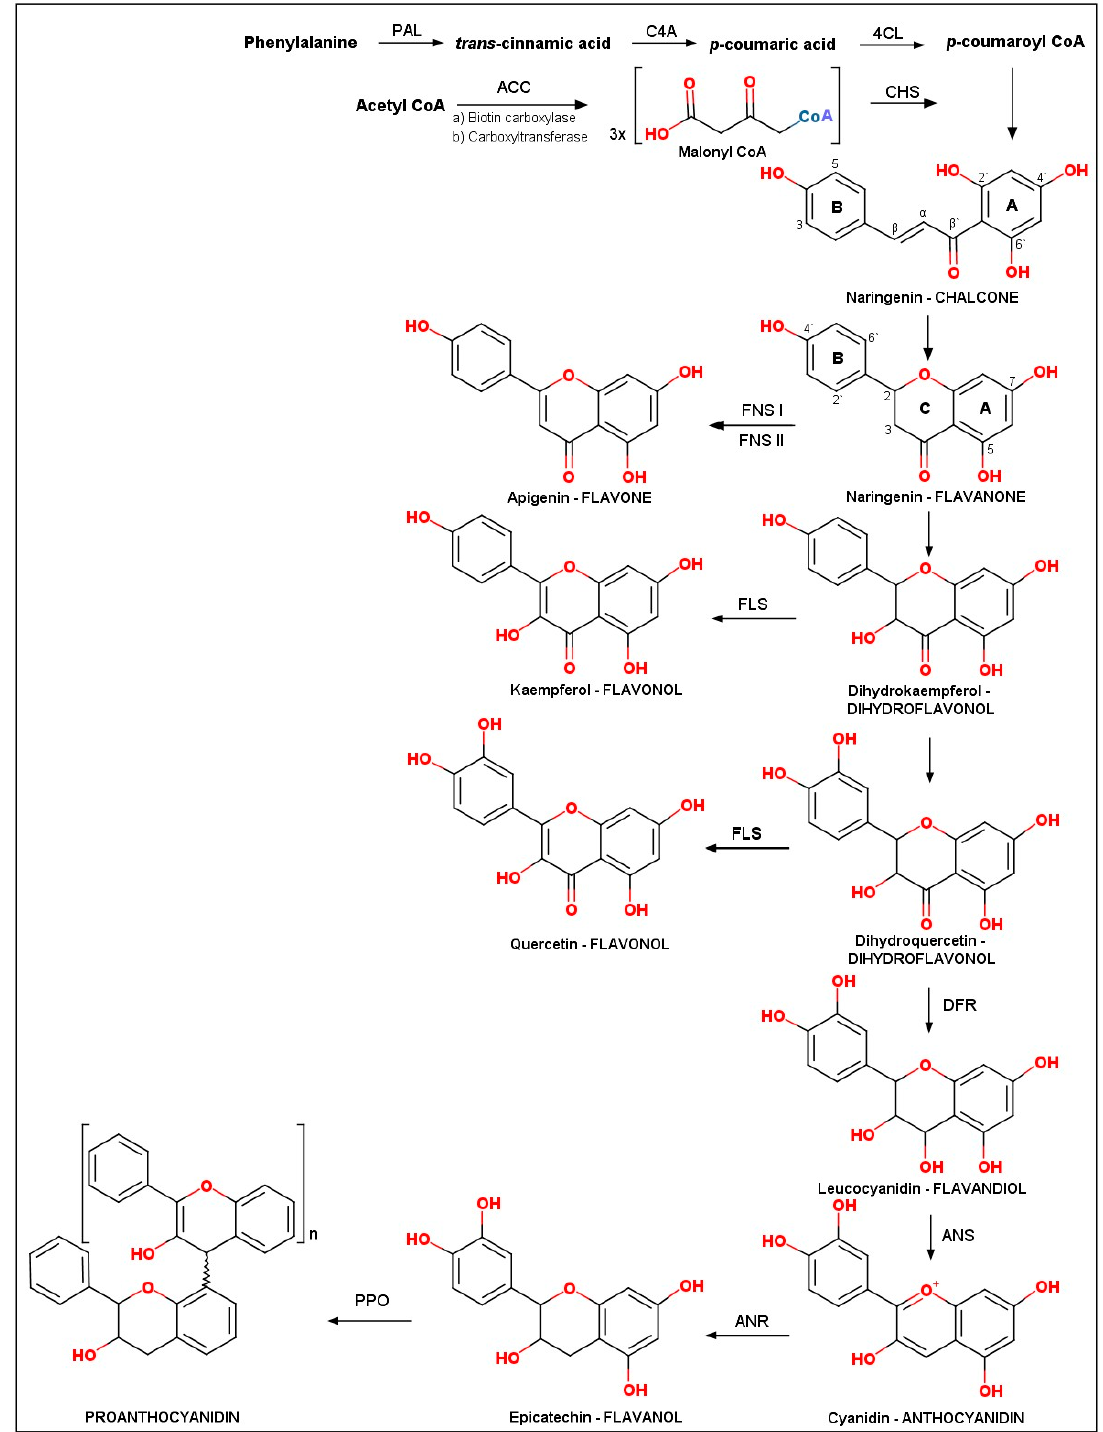
Figure 3. Schematic of the major branch pathways of flavonoid biosynthesis. Adapted from [28]. PAL, phenylalanine ammonia-lyase; C4H, cinnamic acid 4-hydroxylase; 4CL, 4-coumaric acid: CoA ligase; ACC, acetyl-CoA carboxylase; CHS, chalcone synthase; CHI, chalcone isomerase; FNS I/FNS II, flavone synthases; F3H, flavanone 3-hydroxylase; F3‘H, flavonoid 30-hydroxylase; FLS, flavonol synthase; DFR, dihydroflavonol 4-reductase; ANS, anthocyanidin synthase; ANR, anthocyanidin reductase; PPO, polyphenol oxidase.